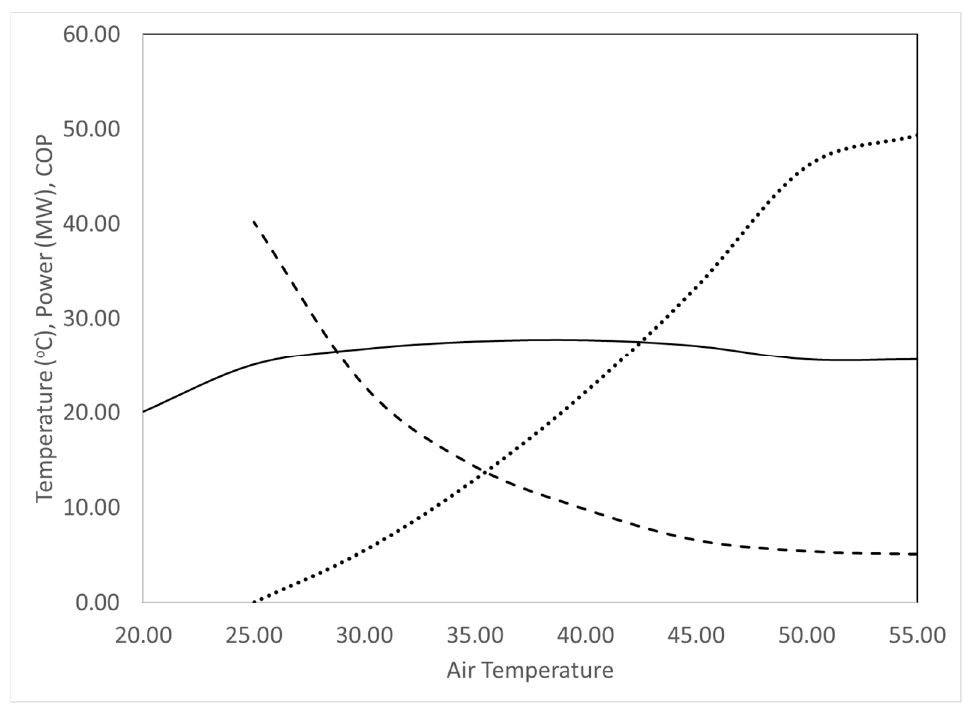
Figure 8. Effect of ambient air temperature on cooling fluid inlet temperature (continuous line), compressor power requirement (dotted line) and CoP (dashed line).